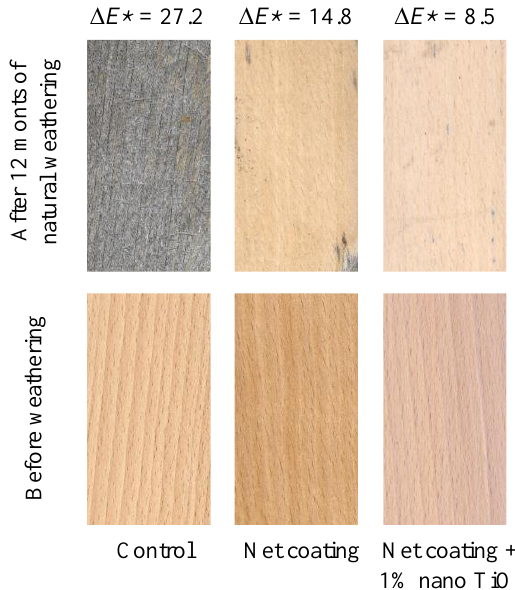
Figure 1. Colour change of uncoated (control) and coated beech wood with net coating and net coating with 1% nano TiO 2 after 12 months of natural